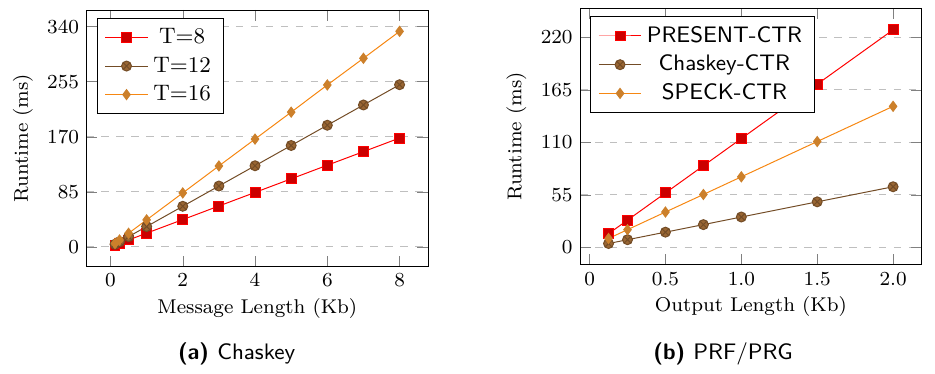
Figure 6: Runtimes of Chaskey and PRF / PRG